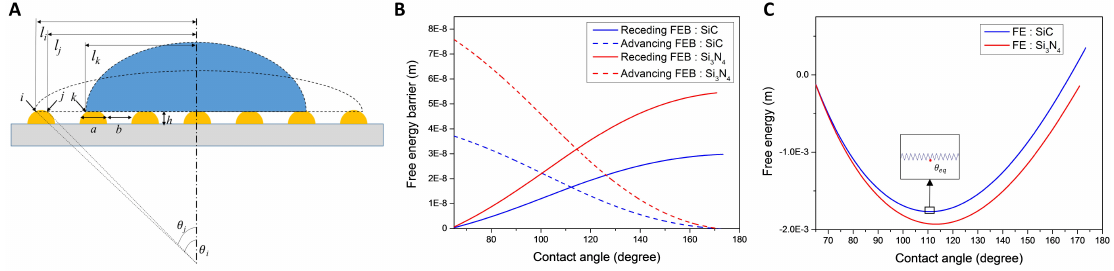
Figure 3. A thermodynamic approach for estimating the free energy and free energy barrier on SiC and Si 3 N 4 substrates. ( A ) A schematic illustration of the cross-sectional configuration of a liquid drop on AuNI covered substrate; ( B ) Receding and advancing free energy barriers; and ( C ) Free energy of a liquid drop on the Au nanostructure deposited SiC and Si 3 N 4 substrates. Inset graphs show the variation in the local energy barriers, indicating metastable and stable